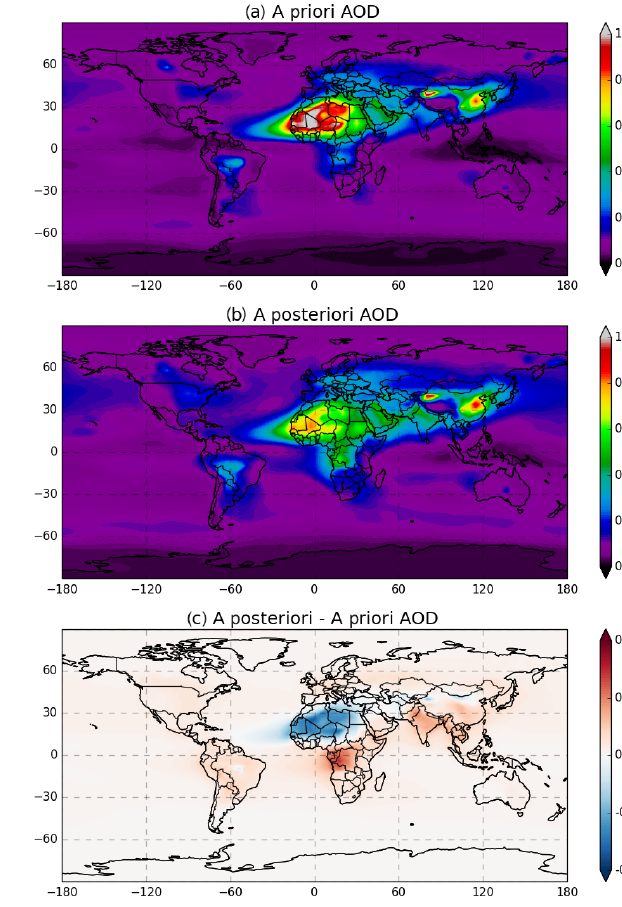
Figure 4. Comparison of GEOS-Chem simulation of global aerosol optical depth in the year 2010 at 550nm based upon a priori and a posteriori emission datasets: (a) a priori AOD, (b) a posteriori AOD and (c) a posteriori minus a priori